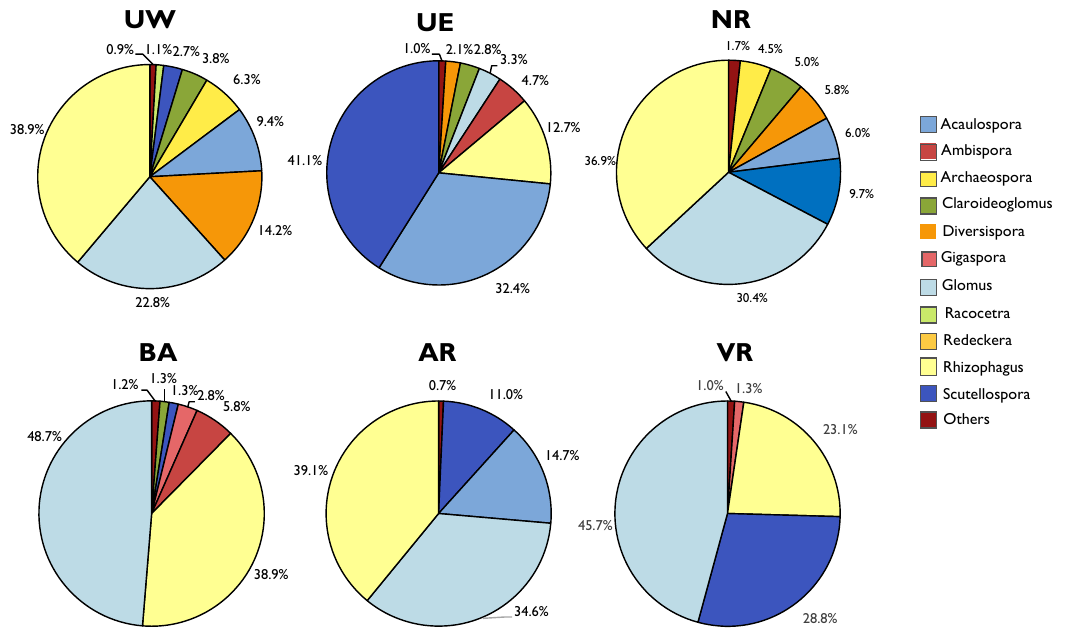
Values are mean ± SE (n = 3). Different letters indicate statistically significant differences ( P < 0.05) between regions according to the Tukey–Karmer (T) test.